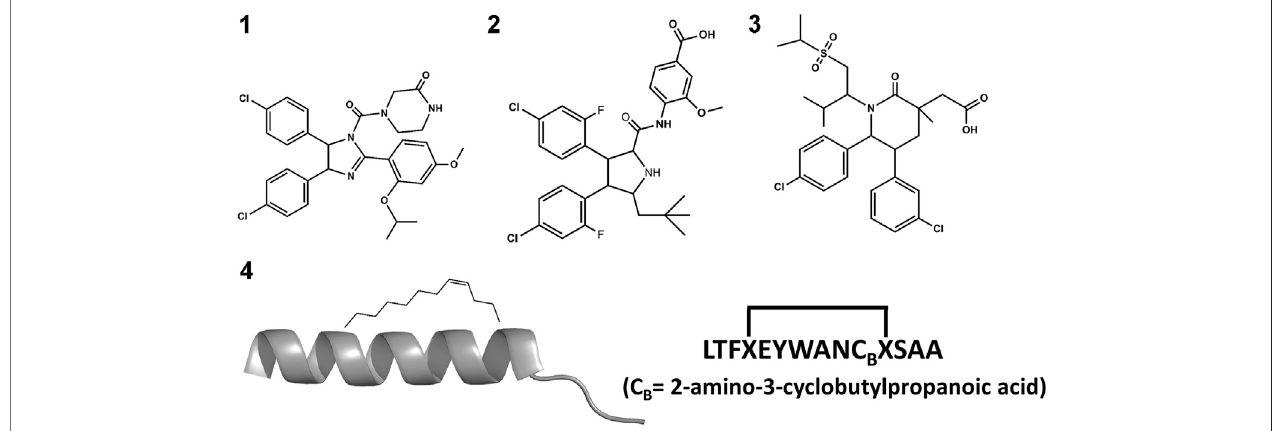
FIGURE 3 | Chemical structures of nutlin-3a (1); idasanutlin (2); AMG-232 (3) and ATSP-7041